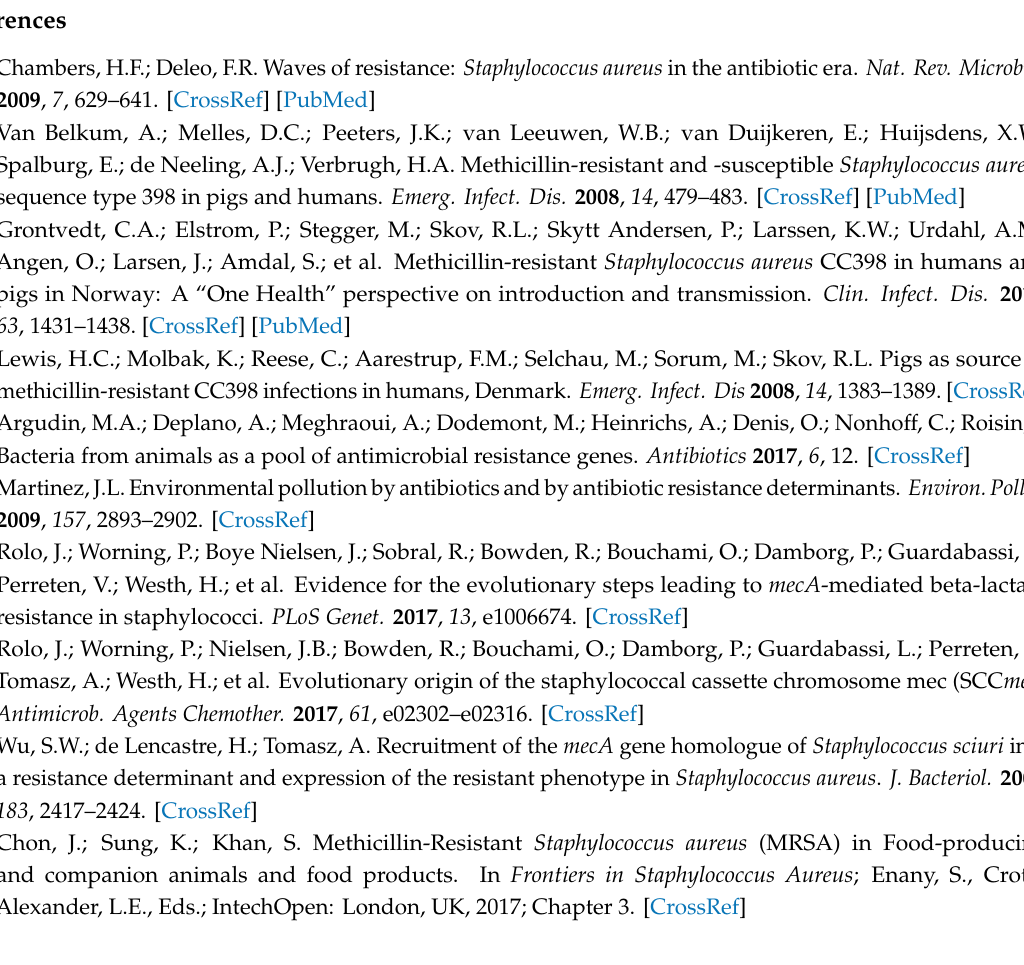
Table S1: Phenotypic and genotypic characterization of 32 MRSA ST398 isolated from slaughterhouse and hospital based on PCR amplification, Table S2: Virulence and antimicrobial resistance determinants of 9 MRSA ST398 isolated from slaughterhouse and hospital based on WGS, Figure S1: Pulsed-field gel electrophoresis (PFGE) typing of MRSA ST398 isolates. The dendrogram showing the clustering of strains was performed by the analysis of PFGE profiles with the BioNumerics software, with 1.25% tolerance and 0.5% optimization. PFGE types and subtypes defined by groups formed at 80% and 95% Dice similarity cuto ff s,